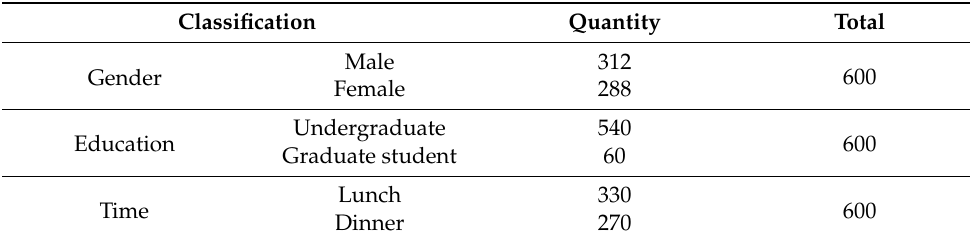
Table 1. Sample distribution.